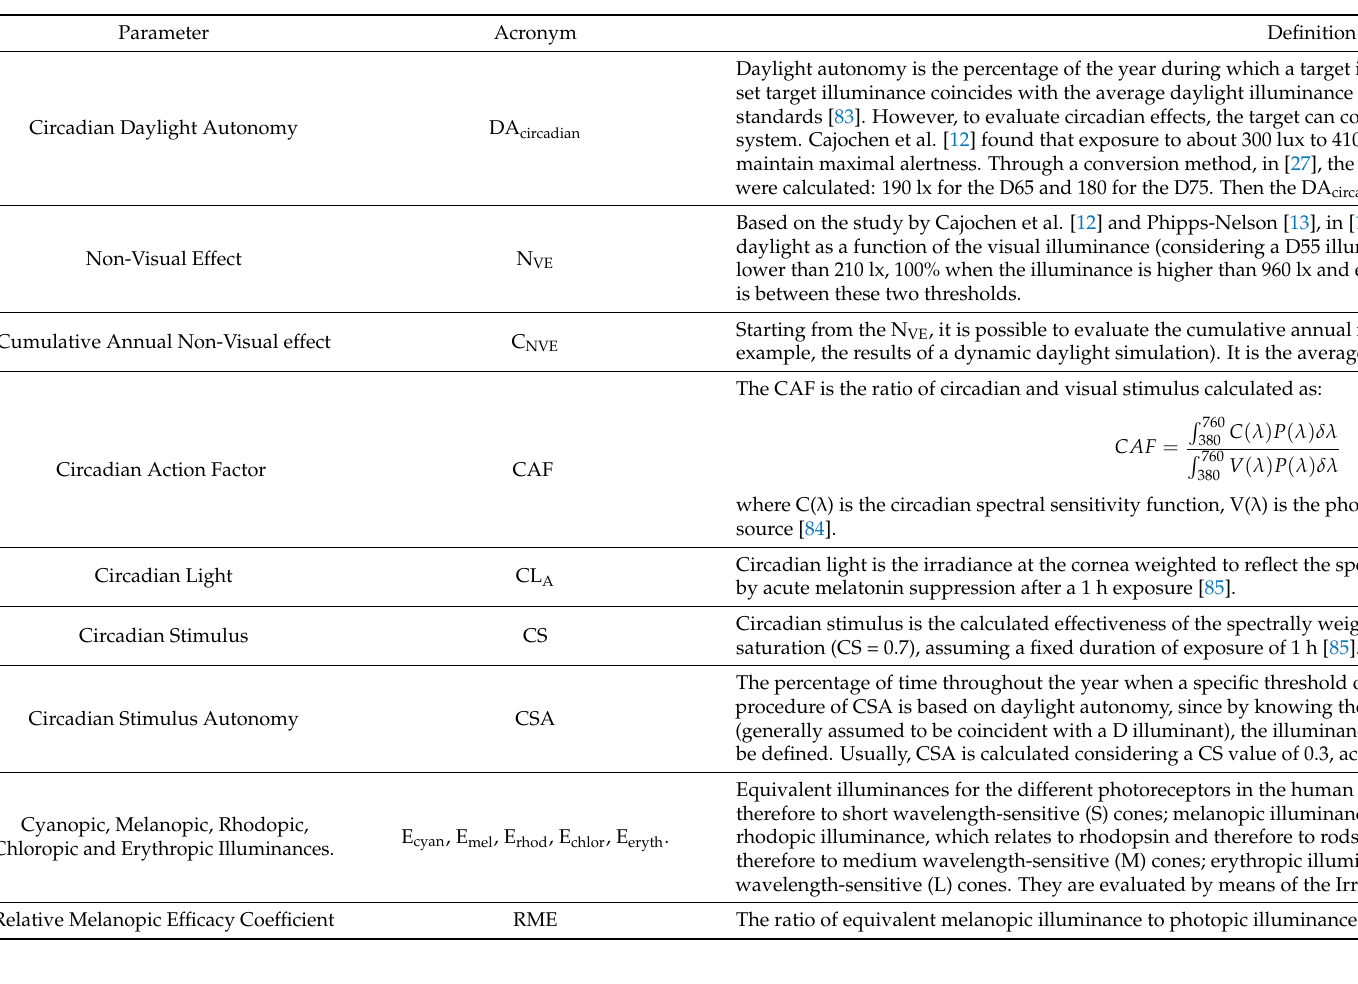
Table A1. Definitions of circadian performance